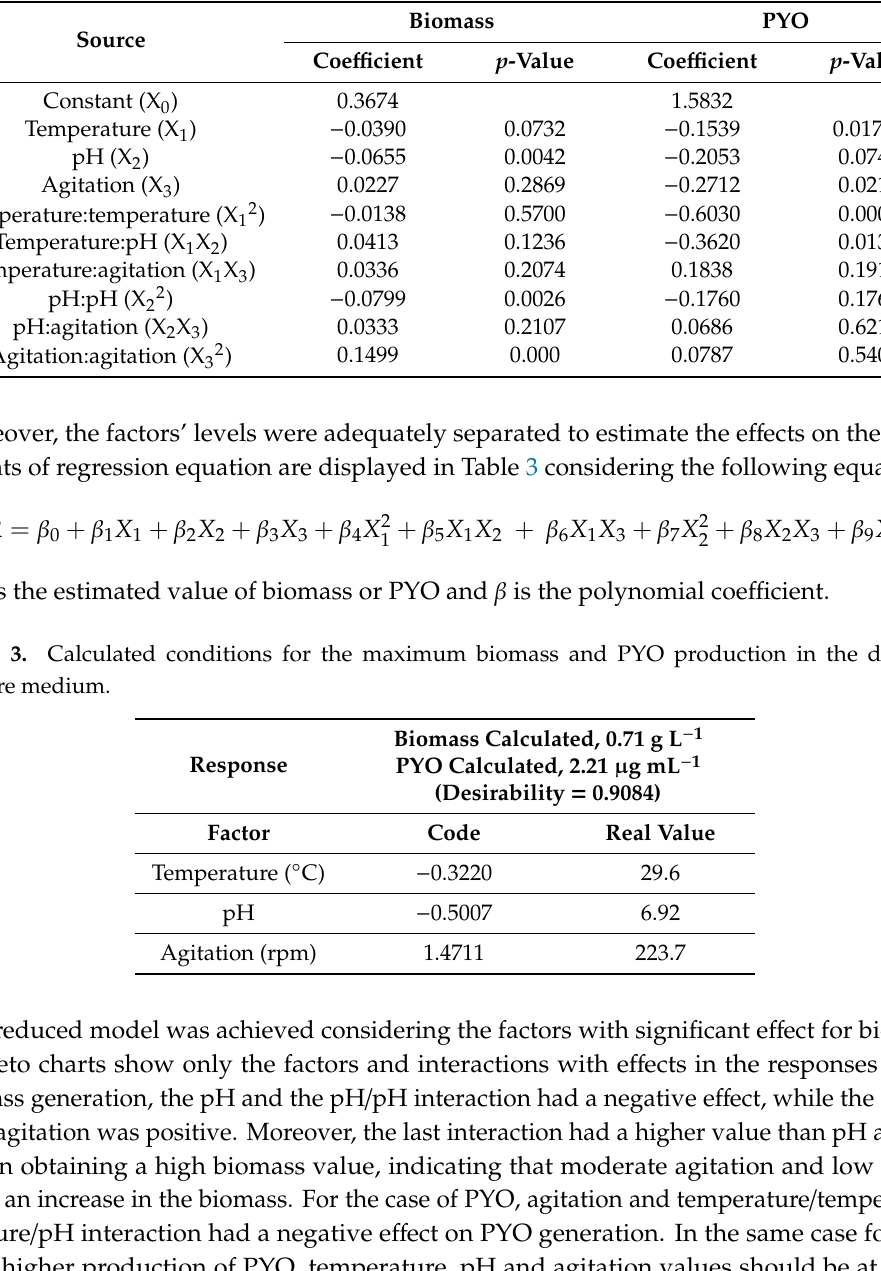
Table 2. ANOVA for biomass and PYO generated from the defined culture medium.